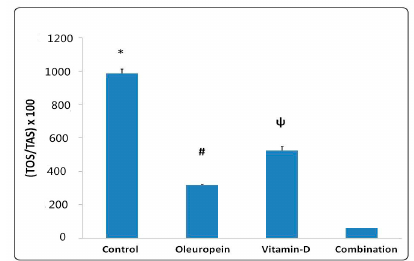
Figure 2. Total oxidant, antioxidant status analysis and oxidative stress index analysis results. # Oleuropein treatment has significantly decreased OSI as compared to vitamin D treatment ( p < 0.05). Combination treatment has significantly decreased OSI as compared to oleuropein treatment ( p < 0.05). Ψ Combination treatment has significantly decreased OSI as compared to vitamin D treatment ( p < 0.05).